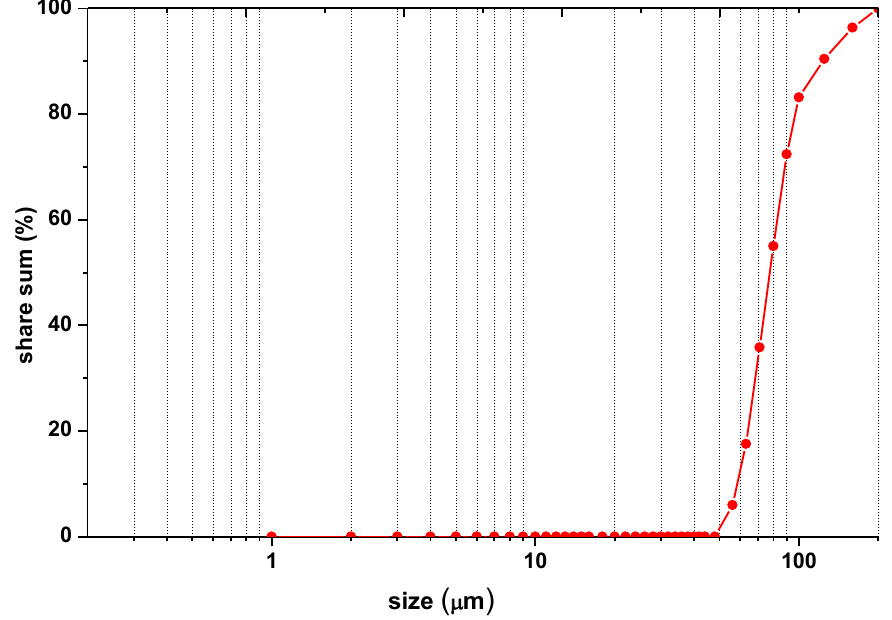
Figure 10. Distribution of grain classes for the initial material for lysimeter tests. The analysis of the results confirmed the correct method of preparation of the material for column tests, in accordance with the assumptions of the adopted methodology. The grain distribution shown in Figure 10 provided a reference for the results obtained for the material from the selected columns. The results of grain analyses of material taken from the top, center, and bottom of the columns of each selected column (columns 1, 3 and 6) are presented in Figures